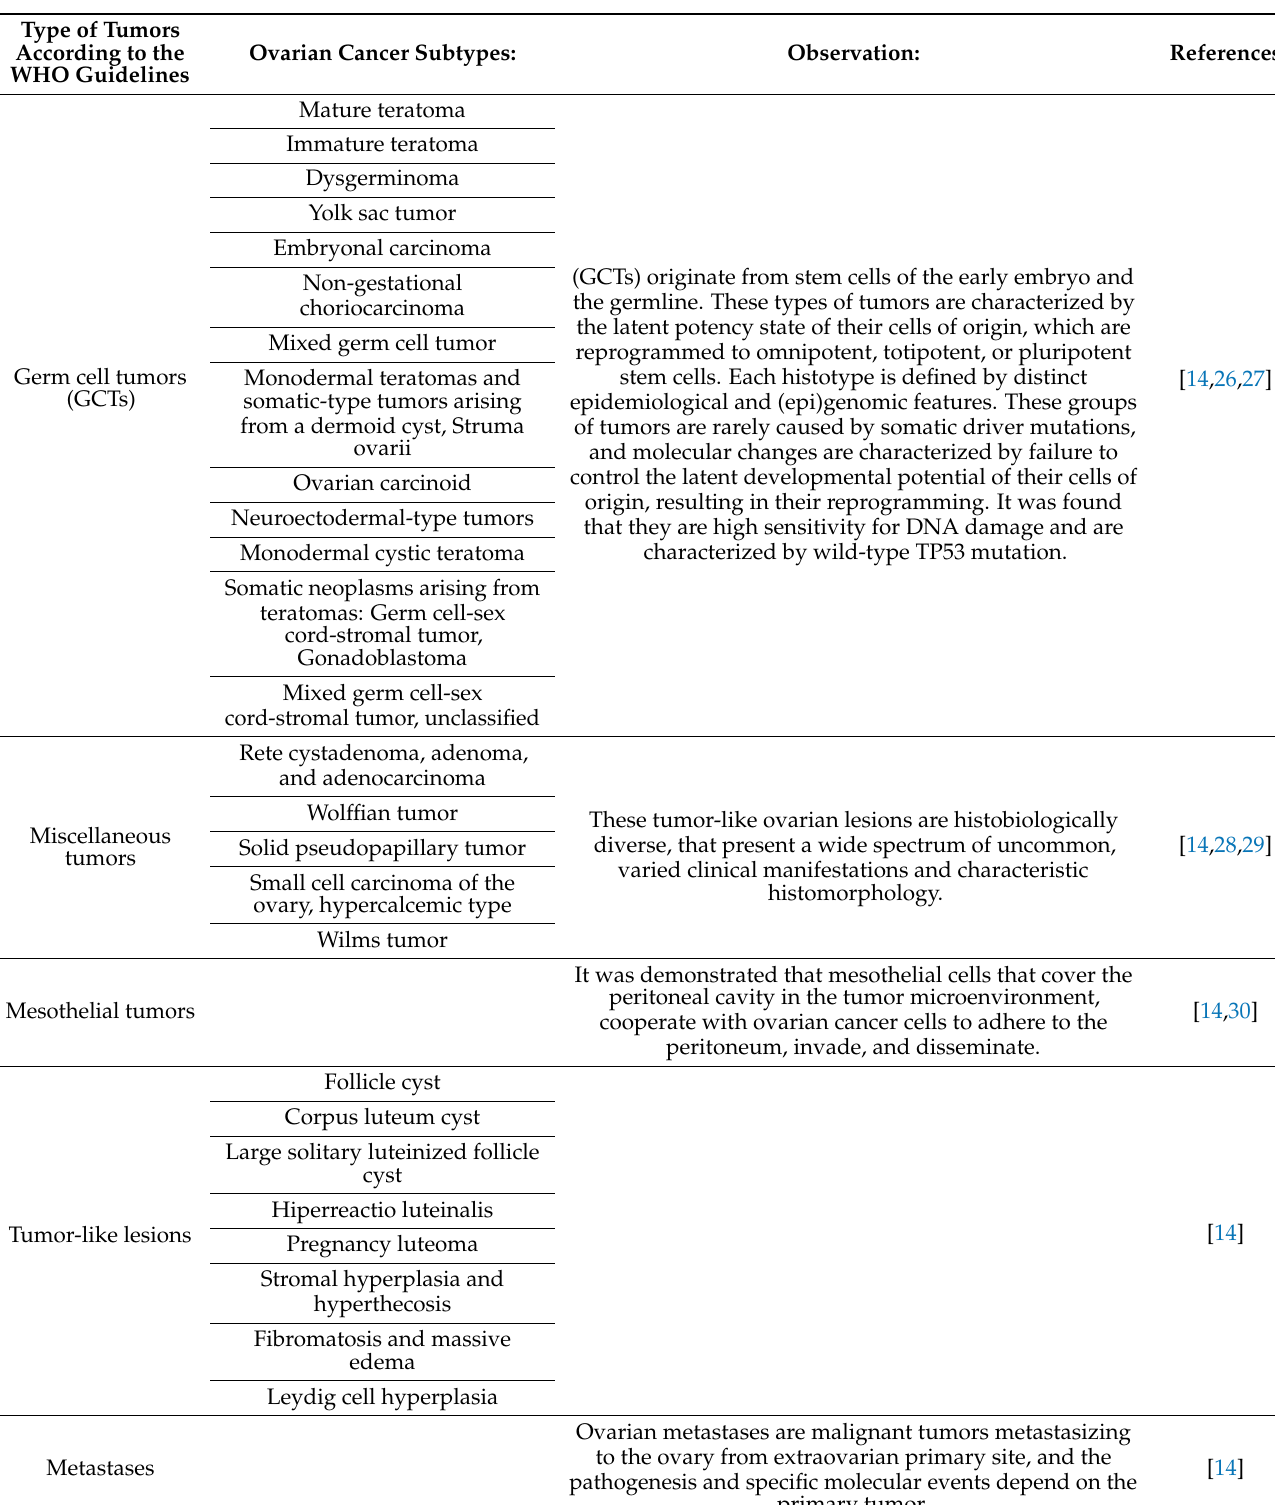
3 factors:—the size of the tumor, the spread to nearby lymph nodes, and the